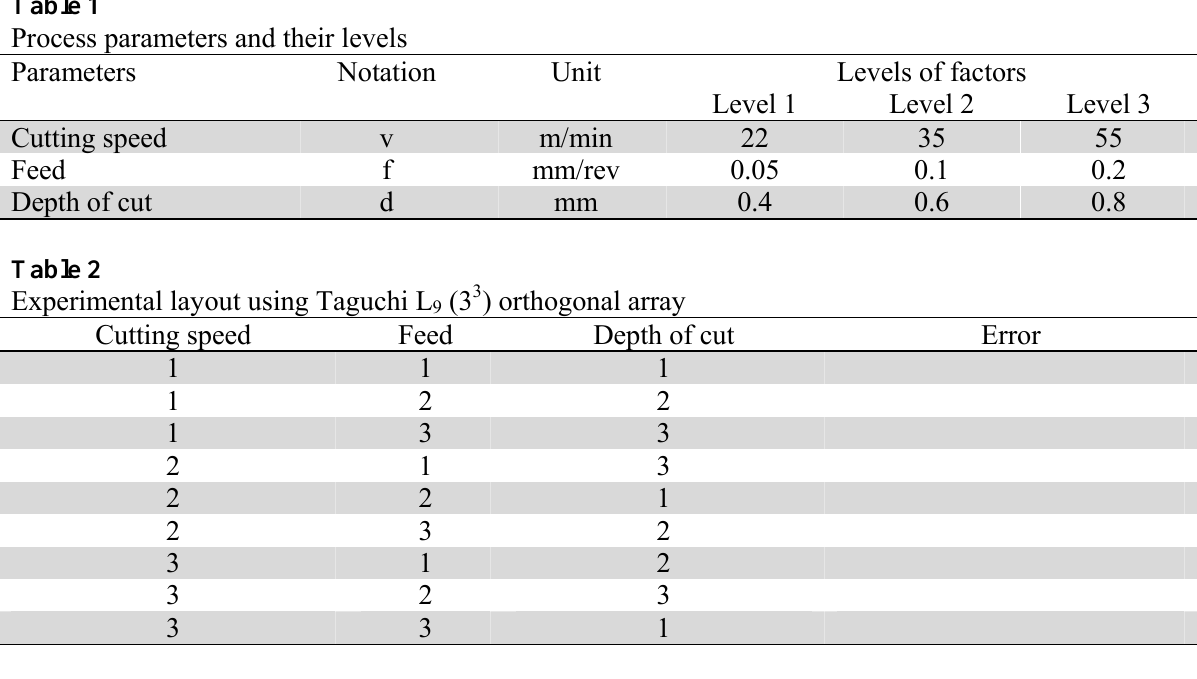
Process parameters and their levels Parameters